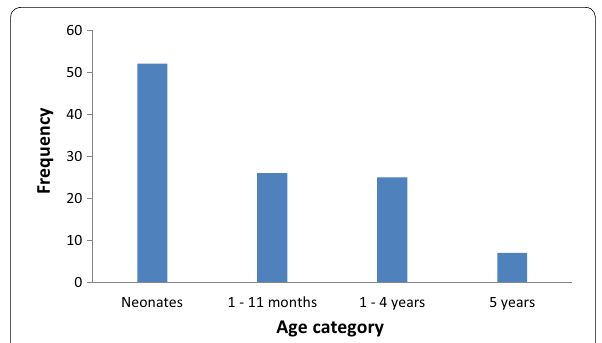
Fig. 1 Age categories of all circumcised boys